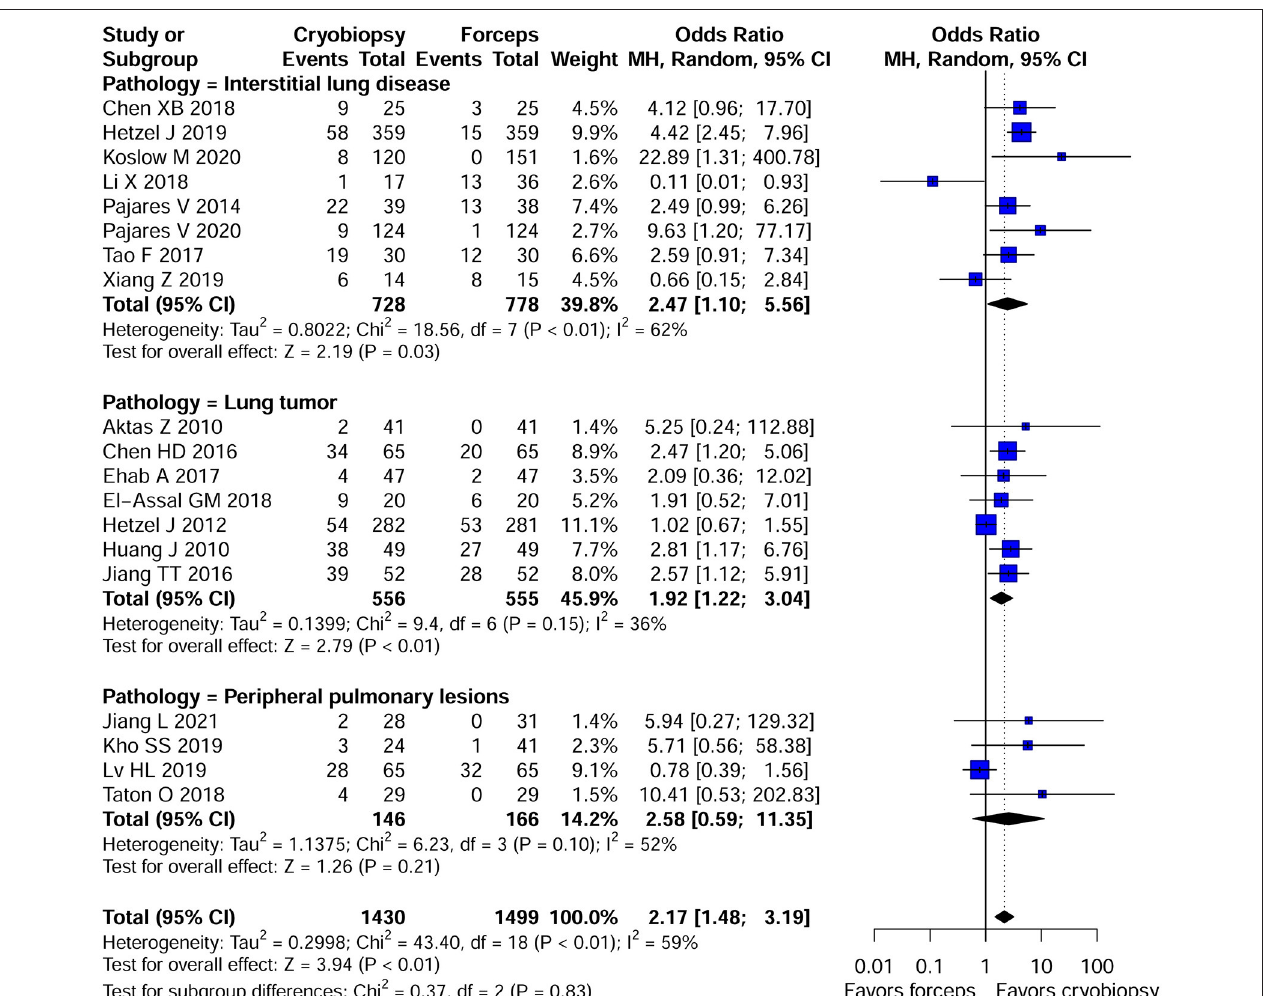
FIGURE 4 | Forest plot of moderate to severe bleeding between the cryobiopsy and forceps biopsy. Subgroup analysis revealed that there were significant differences in the moderate to severe bleeding between the cryobiopsy and forceps biopsy in ILDs and lung tumors subgroups ( < 0.05) but not in PPLs subgroup ( p > 0.05). CI, confidence